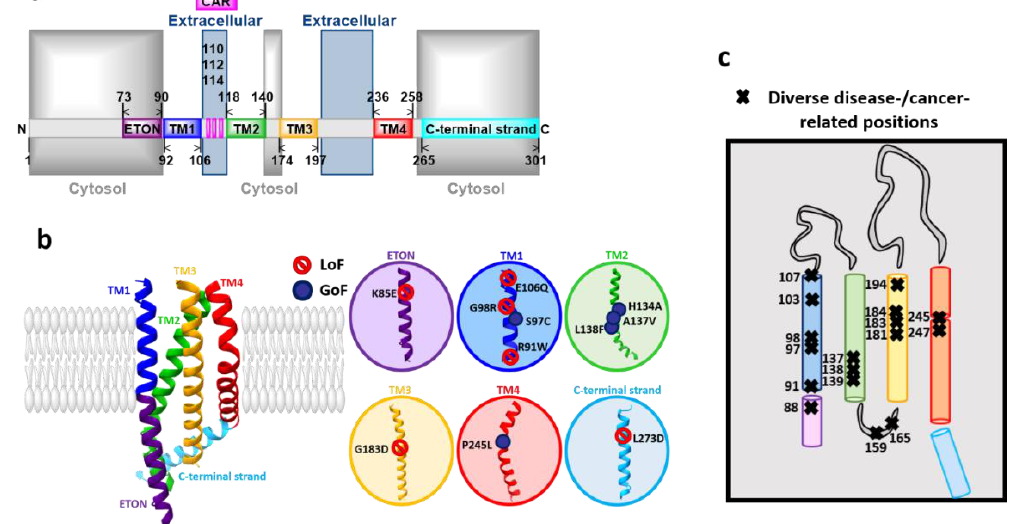
Figure 3. The structural features of the Orai1 channel. ( a ) The scheme shows the full-length human Orai1 channel with highlighted regions and residues that are essential for the Orai1 function. ( b ) The cartoon of one Orai1 subunit with four TM segments along with N- and C- terminal helices are depicted in distinct colors (same as applied within ( a )). The separated circles of the respective Orai1 subunit regions display the most prominent mutations that are known to lead to either loss of function (red stop sign) or gain of function (blue circle) of the Orai1 channel. ( c ) The scheme of Orai1 subunit with marked residues represent positions linked to diverse diseases or cancer.